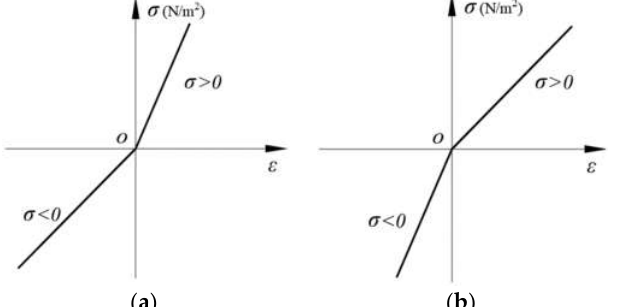
Figure 1. Constitutive model of bimodular materials proposed by Ambartsumyan: ( a ) E + > E − ; ( b ) E + < E − .